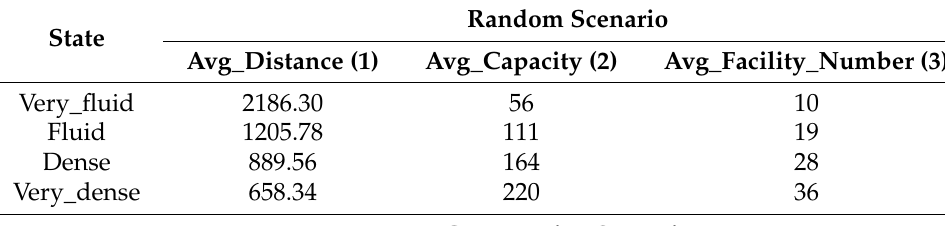
Table 2. Comparative results between constructive scenario and random scenario.